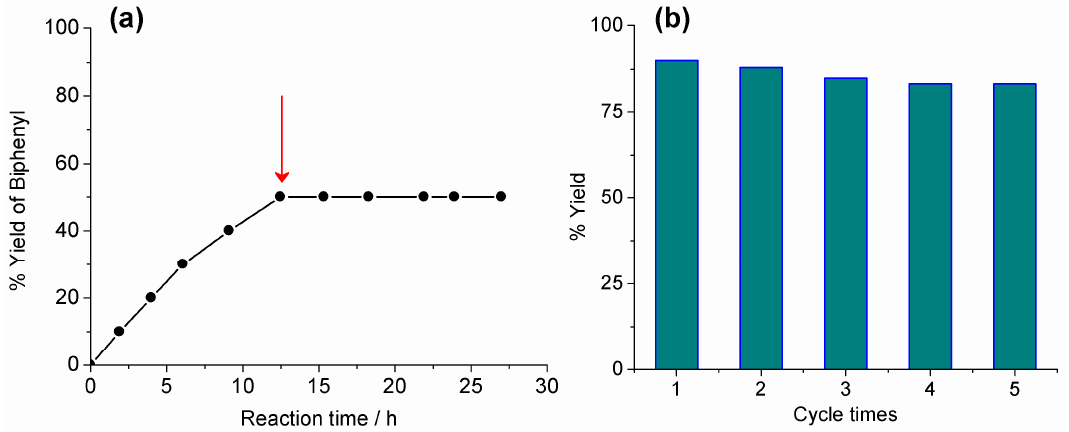
Figure 6. ( a ) Percent yield of biphenyl versus time during a leaching experiment, where the red arrow indicates the time when catalyst was separated and the supernatant was run afterward; ( b ) Recycling study of Pd/PP-3 for Suzuki coupling reaction between iodobenzene and sodium salt of phenyltrihydroxyborate.